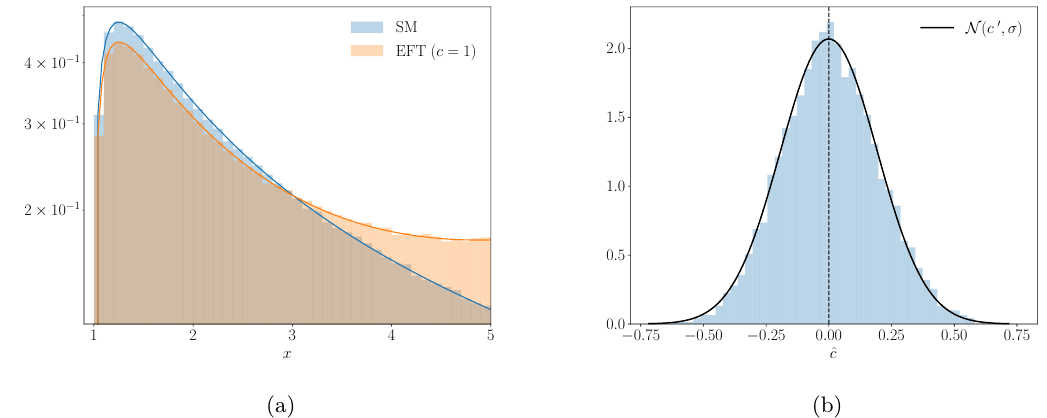
Figure 20. Left: the probability distribution f σ ( x, c ) from eq. (B.1) at c = 1 and c = 0 , corre- sponding to the EFT and SM respectively. Right: the MLE ˆ c under the SM follows a Gaussian distribution centered around c 0 with standard deviation σ